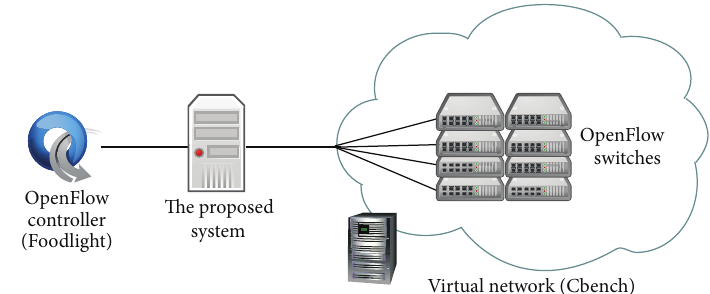
Figure 10: Network topology for evaluating control overhead.